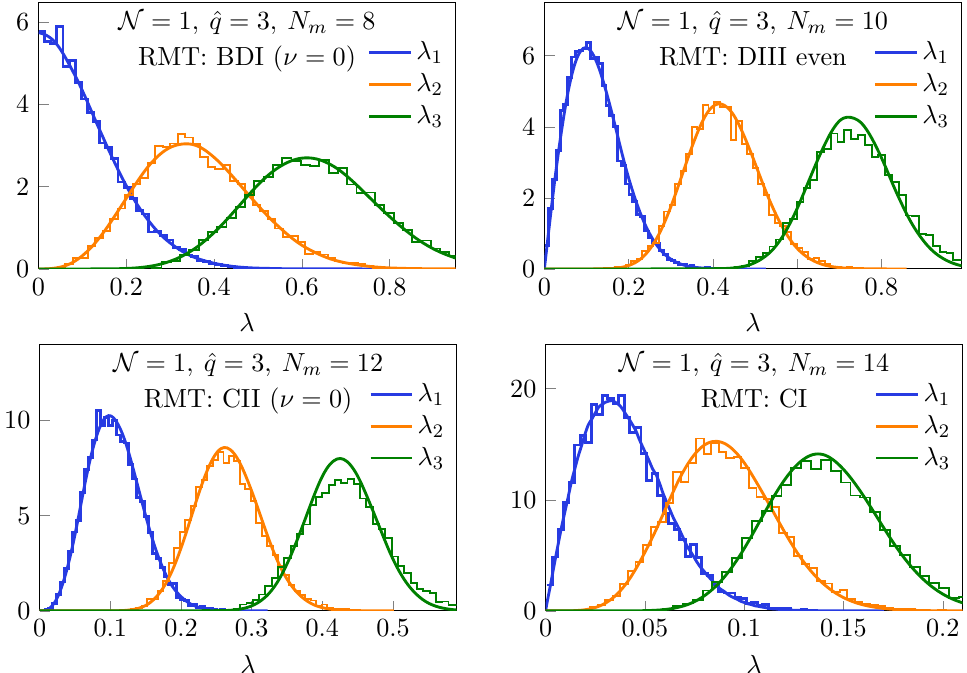
Figure 4 . Distributions of the smallest 3 eigenvalues of Q in (4.1) in the N = 1 SYK model with ^ q = 3 and J = 1, compared with the predictions (solid lines) of the RMT classes in table 5. The number of independent random samples is 10 4 for each plot. As in (cid:12)gure 2, the small deviations from RMT for (cid:21) 3 are interpreted to be e(cid:11)ects of (cid:12)nite N m .